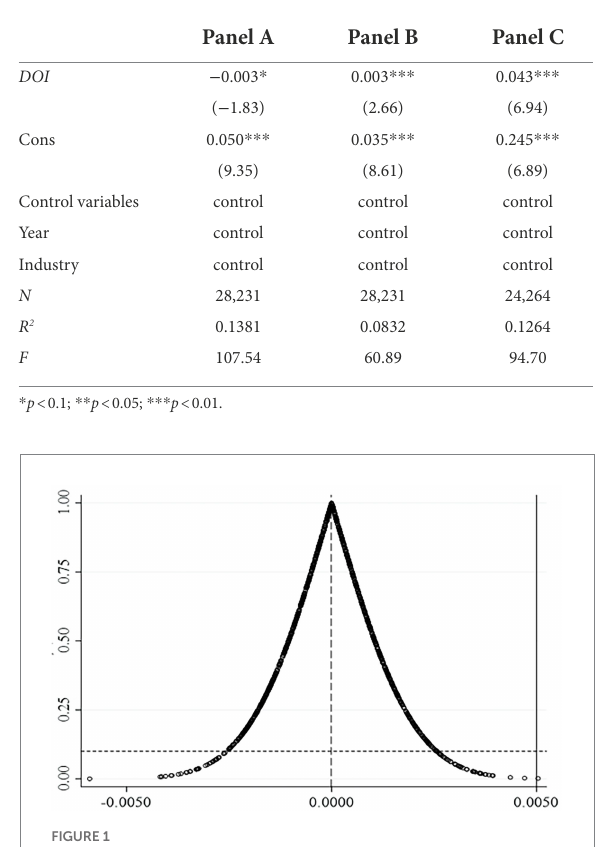
TABLE 8 Robustness test results.